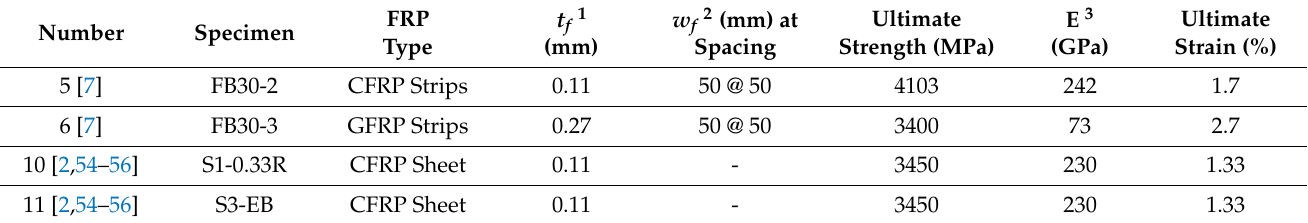
Table 4. Mechanical Properties of FRP